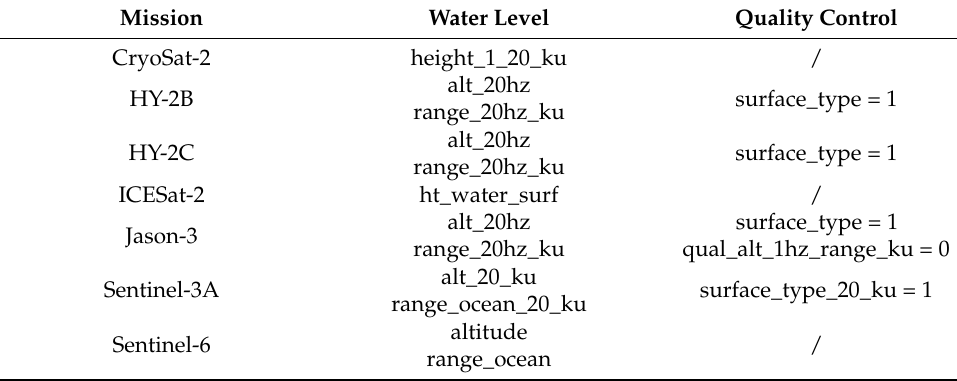
Table 4. Parameters and quality control marks used in satellite measured water